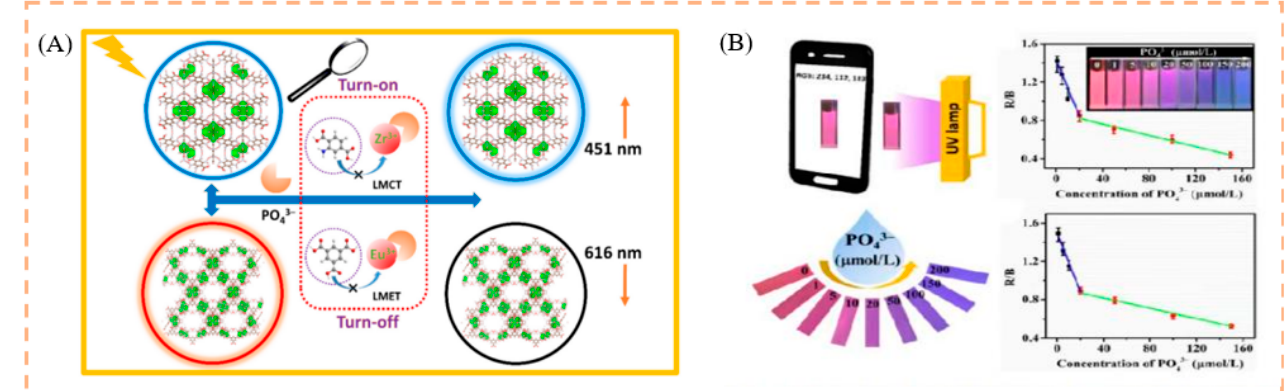
Figure 8. ( A ) Schematic illustration of the detection of phosphate by the RF probe. ( B ) Schematic diagram of phosphate detection by a smartphone. Reproduced with permission from [144]. Copyright 2021, Elsevier.